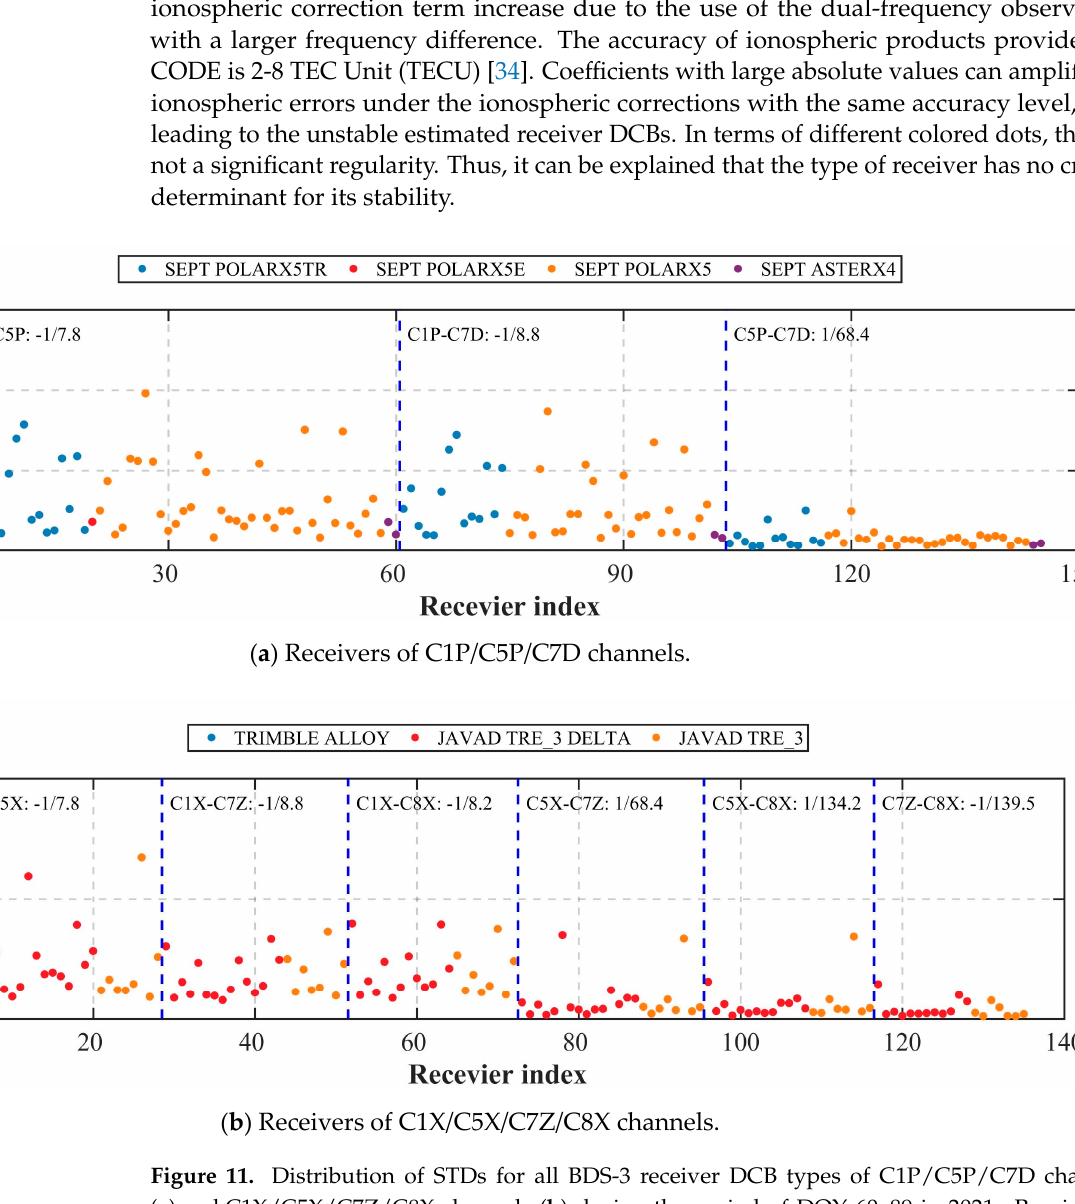
Figure 11. Distribution of STDs for all BDS-3 receiver DCB types of C1P/C5P/C7D channels ( a ) and C1X/C5X/C7Z/C8X channels ( b ) during the period of DOY 60–89 in 2021. Receiver index is arranged according to the classification and order in Table 4. The digitals represent coefficients of the iono- spheric correction with corresponding DCB types.